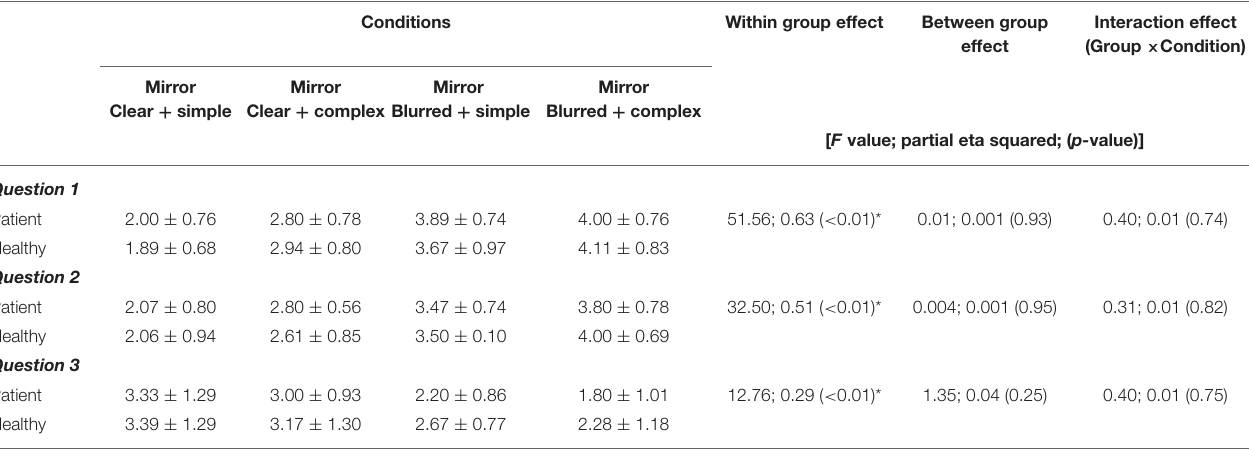
TABLE 5 | Differences in the intensity and authenticity of kinesthetic mirror illusion, and perceived effort of generating kinesthetic sensation across the four experimental conditions for patient ( n = 15) and healthy groups ( n = 18). Conditions Within group effect Between group Interaction effect effect (Group × Condition) Mirror Mirror Mirror Mirror Clear + simple Clear + complex Blurred + simple Blurred + complex [ F value; partial eta squared; ( p-